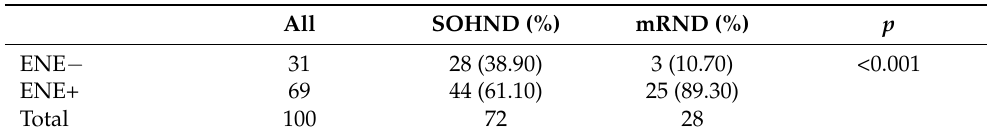
Table 3. Relationship between extranodal extension (ENE) and type of neck dissection in pathologic multiple nodal